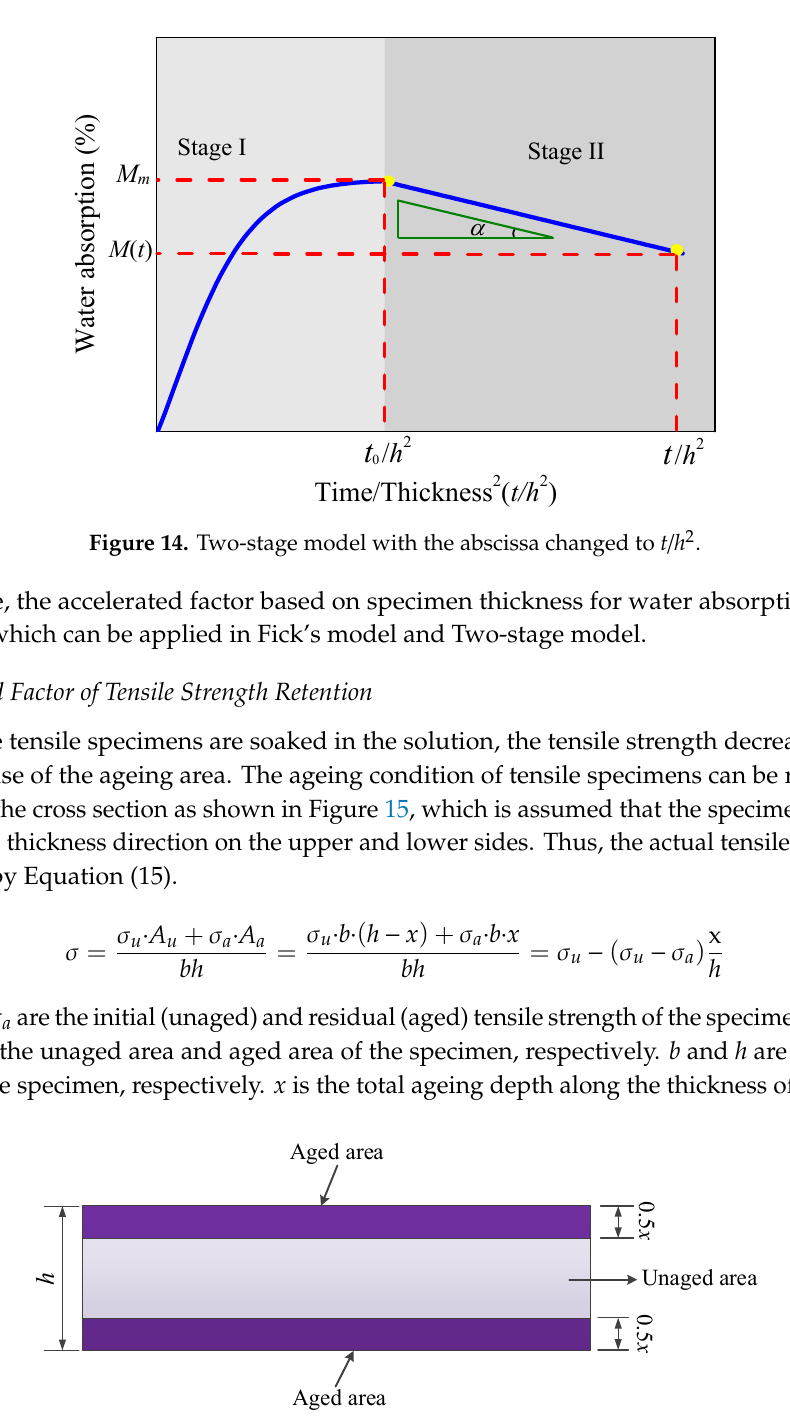
Figure 15. Schematic diagram of ageing along cross section for BFRP laminates.